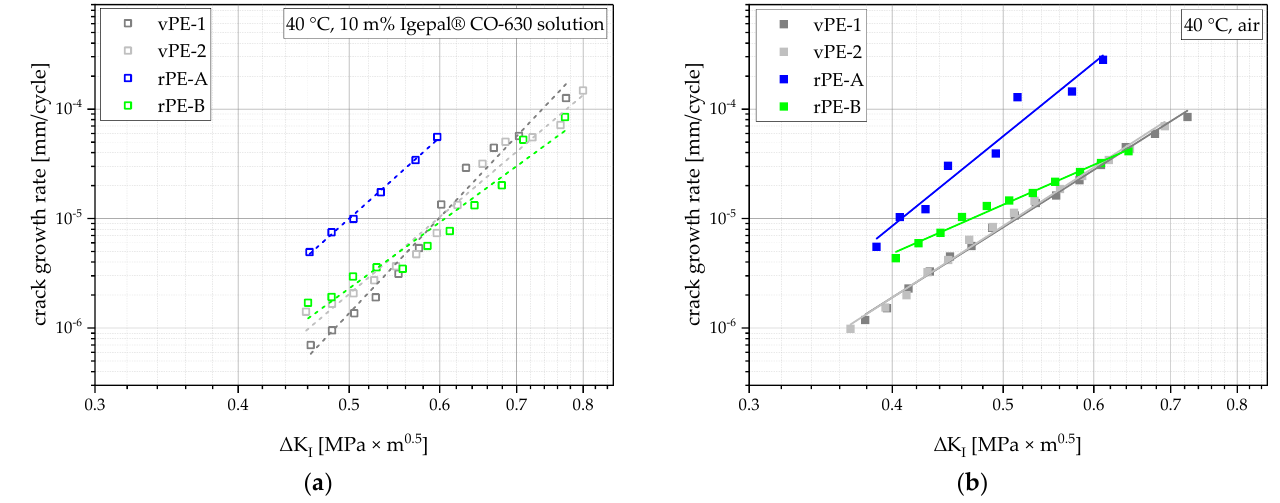
Figure 11. Crack-growth kinetics tested at 40 °C for all materials in a solution of deionized water with 10 m% Igepal CO-630 ( a ) and in air ( b ). Linear fits highlight the stable stress-intensity factor range dependent on crack growth.